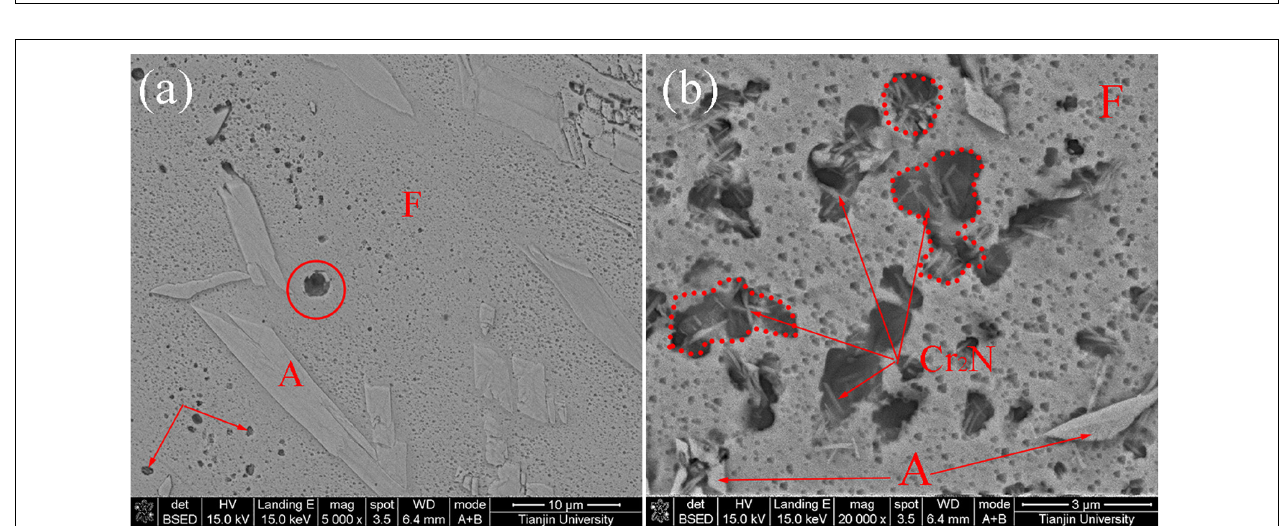
FIGURE 10 | Pits morphologies in HAZ after CPT tests: (a) SEM and (b) high-magnification SEM.